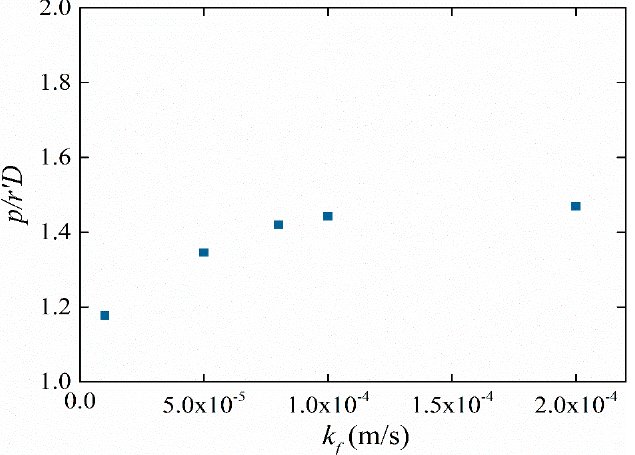
Figure 13. Influence of permeability coefficient k f on suction penetration resistance.